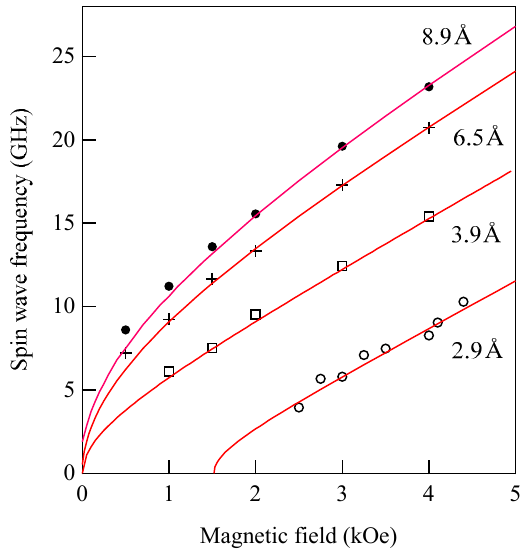
Figure 19. SW frequencies for four Fe thicknesses, 8.9, 6.5, 3.9, and 2.6 Å, as a function of the magnetic field. The solid lines are the SW frequencies calculated by solving numerically the BCD equation [79].